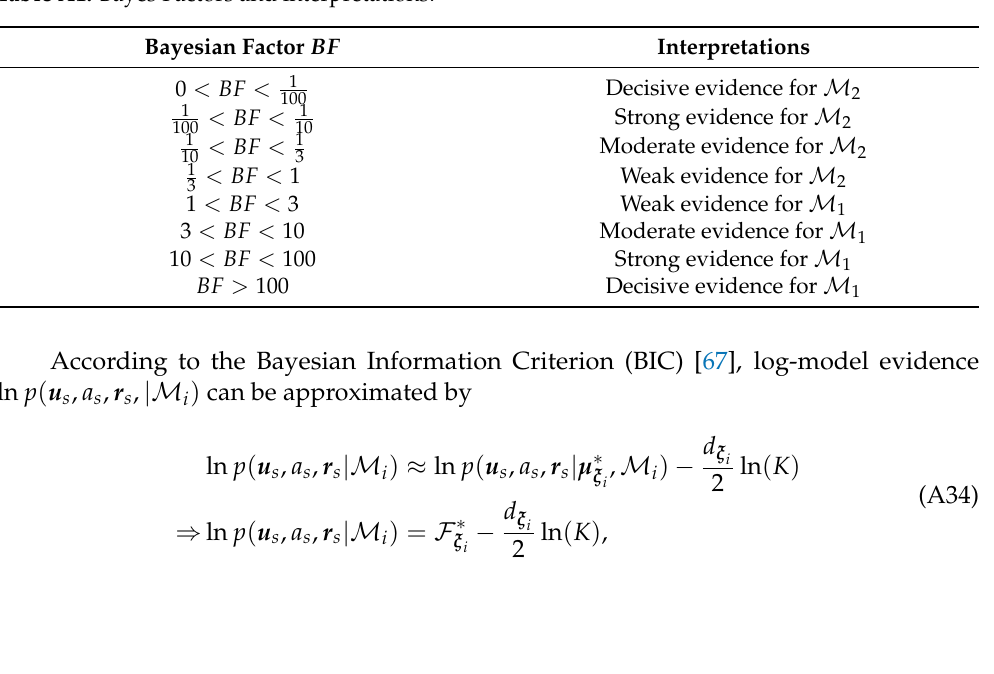
Table A1. Bayes Factors and